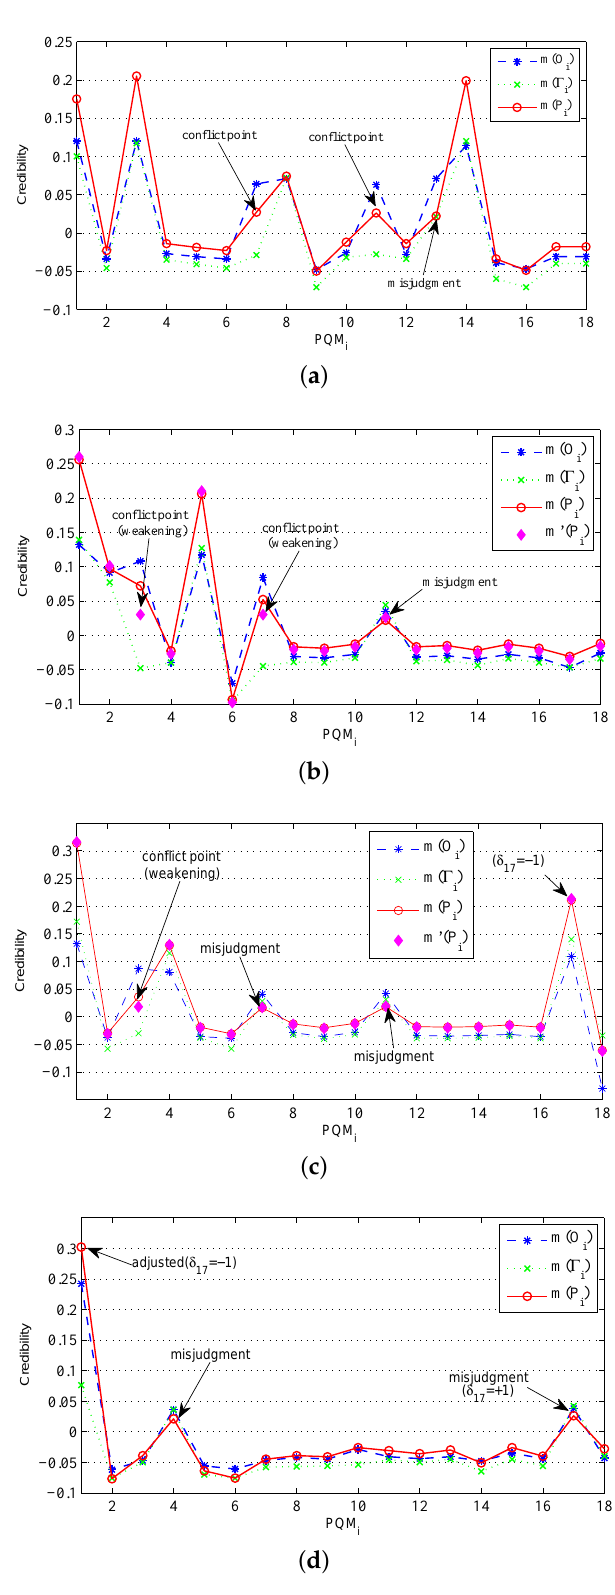
Figure 15. Distribution of basic credibilities and fusion credibilities for each disturbance event. ( a ) Event F 1 ; ( b ) Event F 2 ; ( c ) Event F 3 ; ( d ) Event F 4